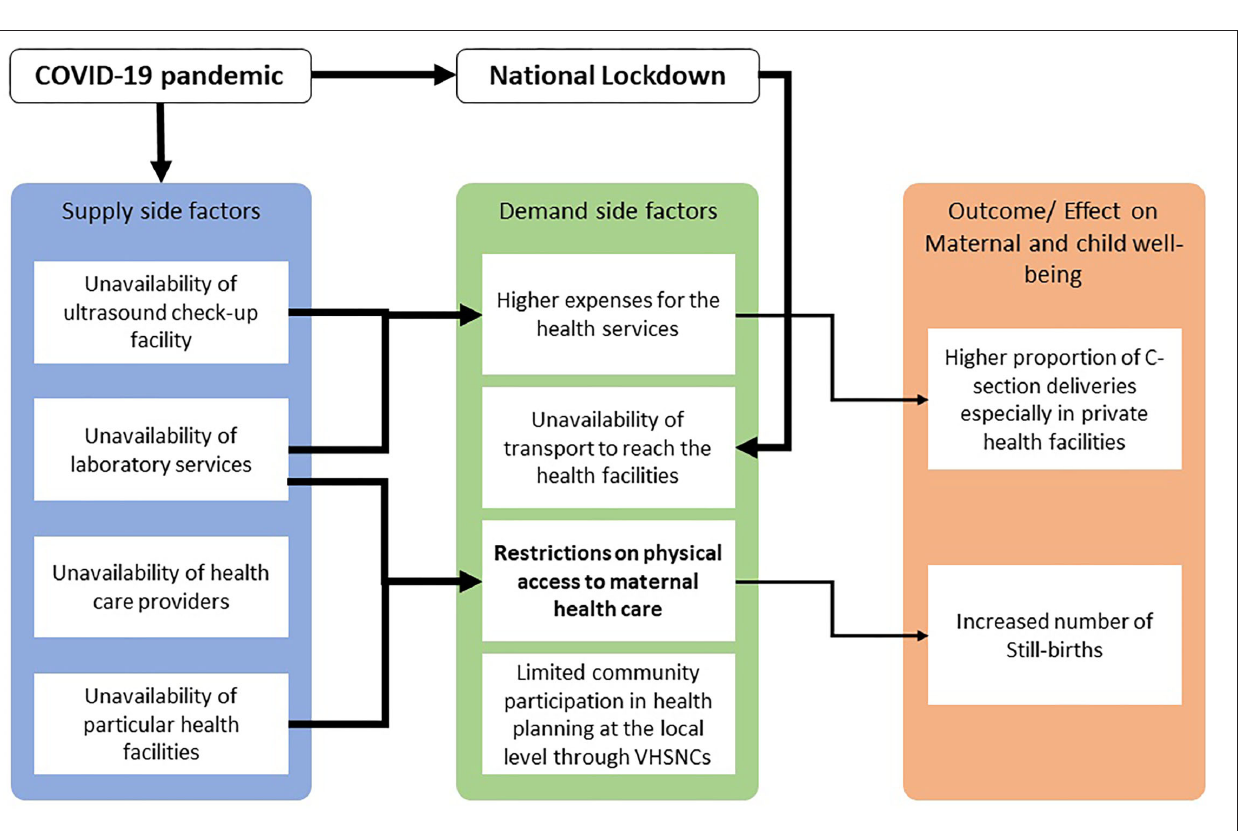
FIGURE 1 | Empirical